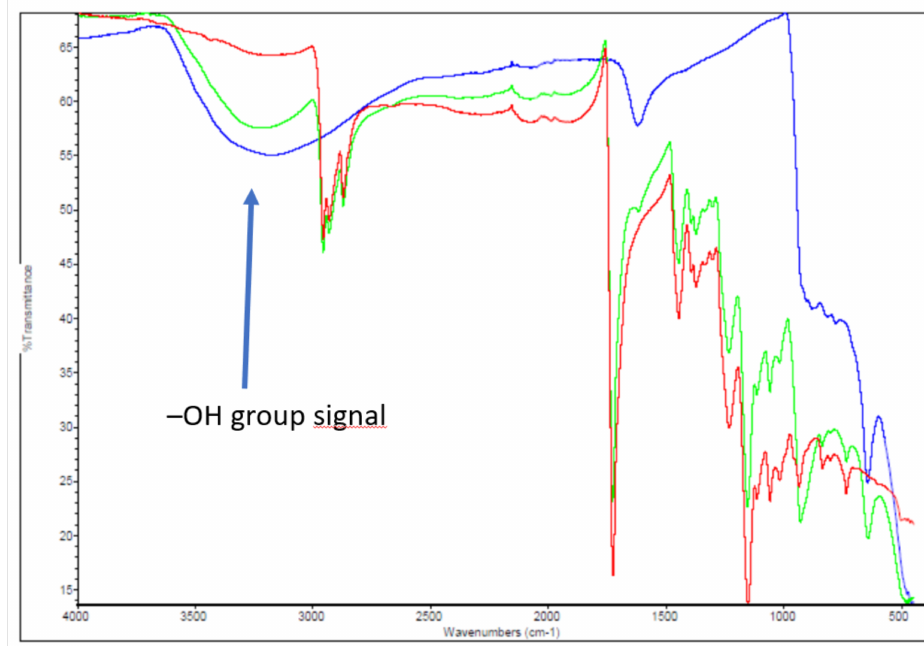
Figure 12. FTIR spectra of sample 3 and sample PDP_4 (Table 1).